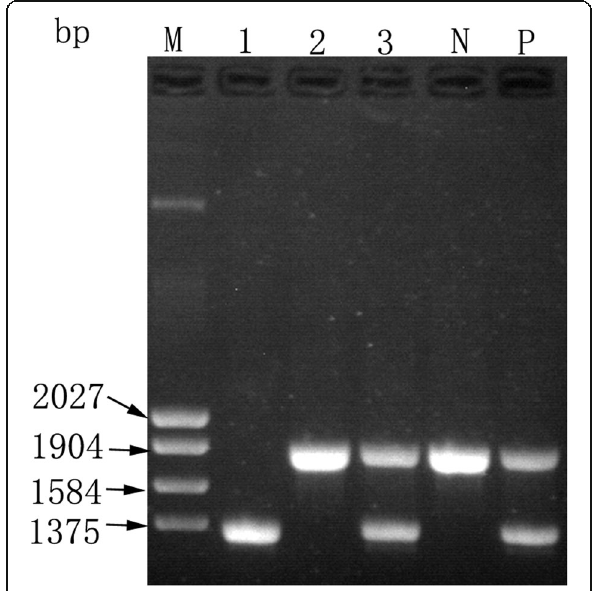
Fig. 1 Common deletion type α -Thalassemia electrophoresis results.1: Proband. 2: Proband ’ s wife. 3: Proband ’ s son. N: Negative control. P: Positive